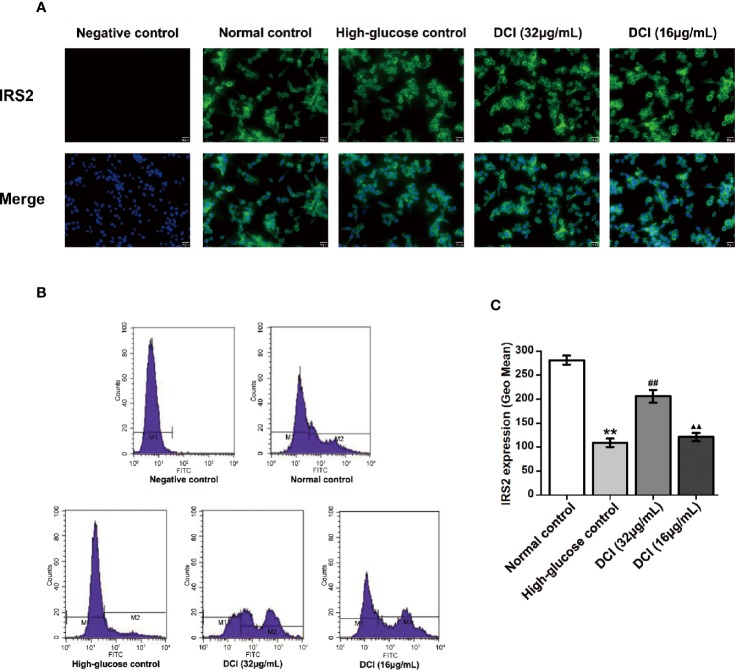
Effects of D-chiro-inositol (DCI) on the expression level of IRS2 protein in high glucose-stimulating HepG2 cells. (A) Representative images of fluorescent staining regarding insulin receptor substrate 2 (IRS2) in high glucose- stimulating HepG2 cells in different groups are listed (200×). (B) Flow cytometry results regarding IRS2 protein in high glucose-stimulating HepG2 cells in different groups were determined. (C) Flow cytometry results regarding IRS2 protein in high glucose-stimulating HepG2 cells in different groups were accounted. All values are expressed as means ± SEM, n=3. **P < 0.01 vs. normal control group cells; ##P < 0.01 vs. high-glucose control group cells; ▲▲P < 0.01 vs. 32 µg/mL DCI group cells.